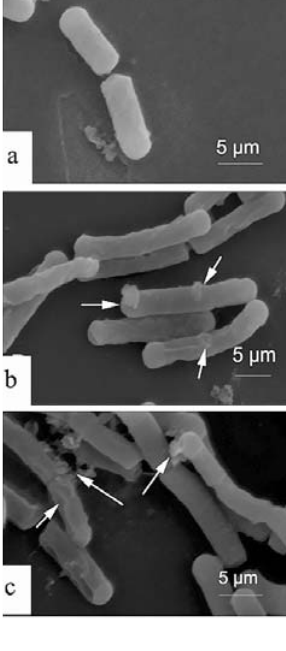
Figure 5. Scanning electron microscopy of Escherichia coli treated with HAHp2-3-I. ( a ) Control, absence of HAHp2-3-I; ( b ), ( c ) treatments, presence of HAHp2-3-I. Bars in figure represented 5 μ m. Micelles, pores, and membrane disruption were marked with